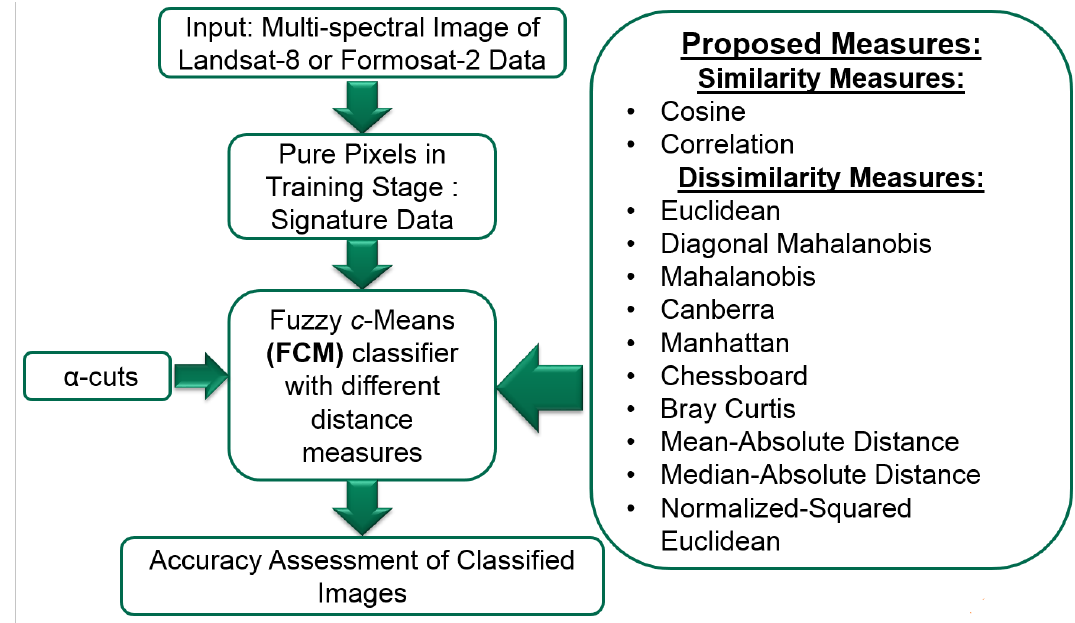
Figure 1. Research methodology.